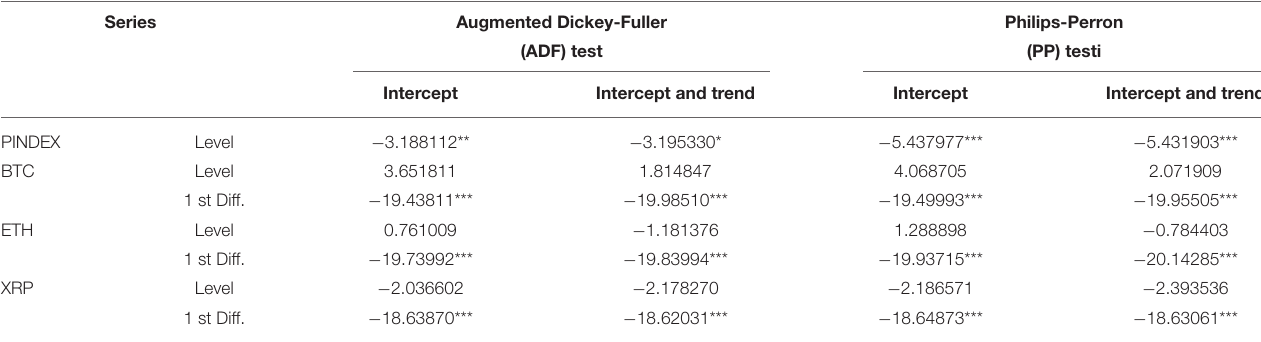
TABLE 2 | Results of unit root